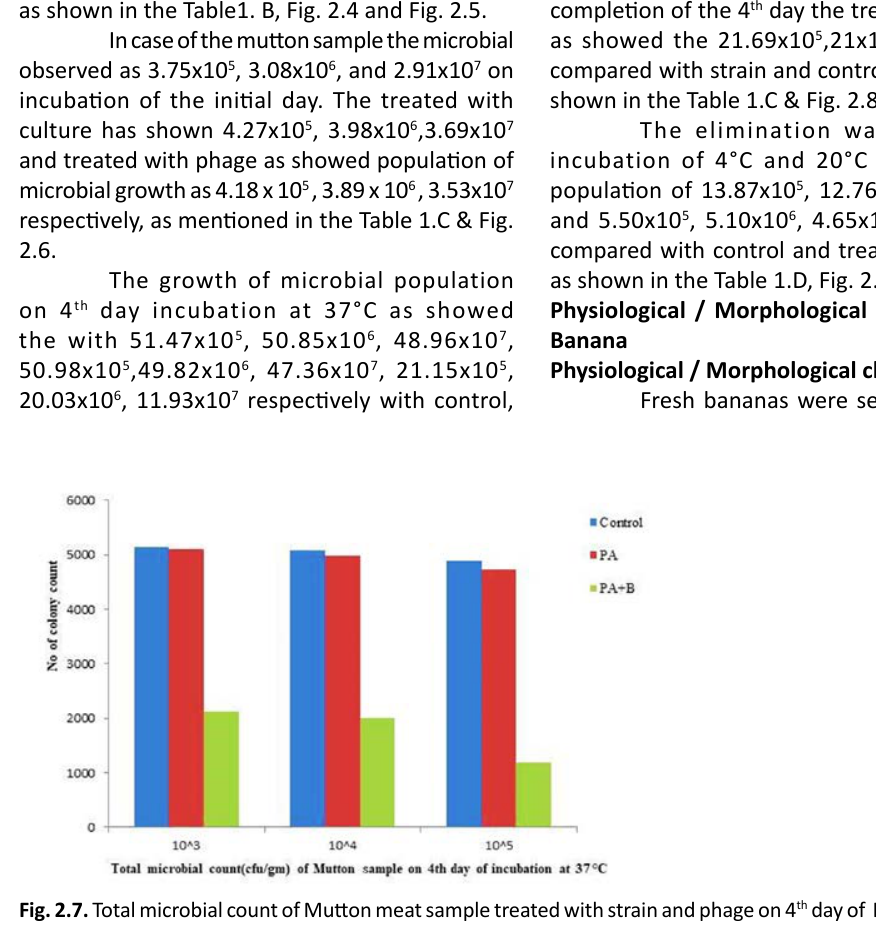
Fig. 2.7. Total microbial count of Mutton meat sample treated with strain and phage on 4 th day of Incubation at 37 °C.